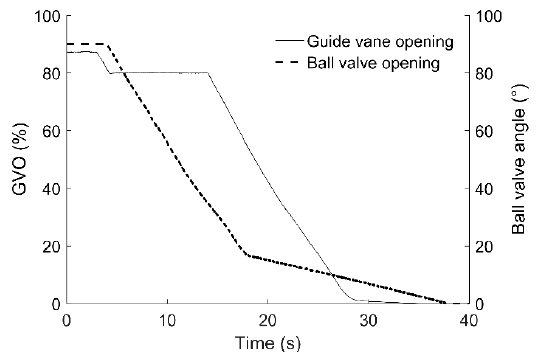
Figure 8. GVCS and ball valve closing schemes (BVCS) in the field test.